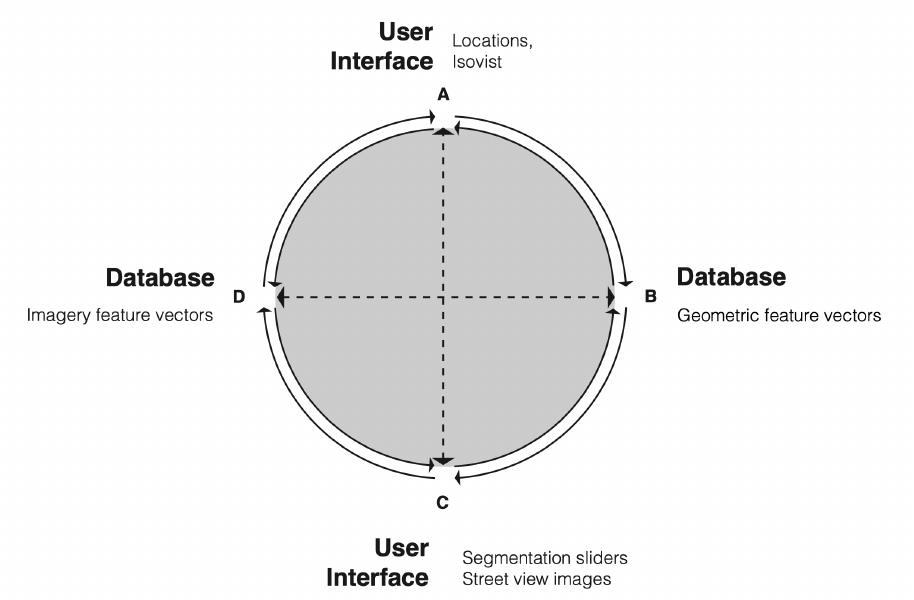
Figure 9. The retrieval loop with 4 ends including 2 user interface ends and 2 database